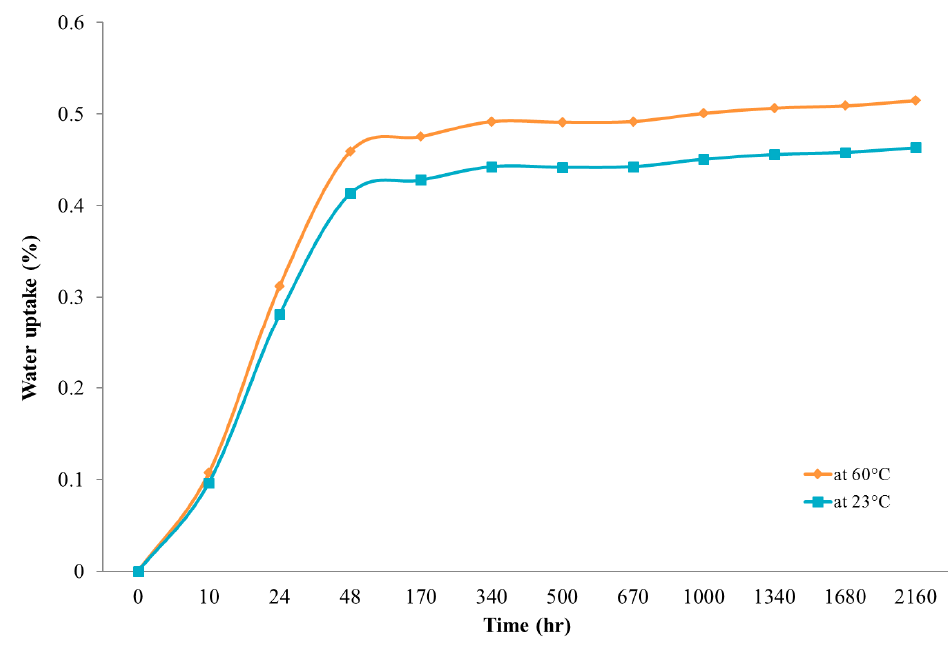
Figure 15. Measurement of water absorption of bamboo composite reinforcement for up to three months.